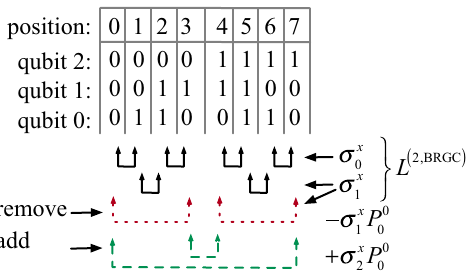
FIG. 2. The three-qubit BRGC Laplacian is constructed from the two-qubit Laplacian and two corrections. The columns under the position index line are the position encoding in qubit states. For example, position state 4 in the second sub-block is encoded as 110 in qubit states. The horseshoe-shaped lines with arrows indicate the symmetric contributions between adjacent positions generating the first row and σ x the second and third rows. with σ x 0 1 The third row, drawn as a red (dotted) line, is an excess contri- in the A = 3 context and is removed by bution generated by σ x 1 − σ x . The last row, drawn with green (dashed) lines, shows P 0 1 0 the missing sub-block end contributions between positions pairs { 0, 7 } and { 3, 4 } , which are added with term σ x P 0 0 2